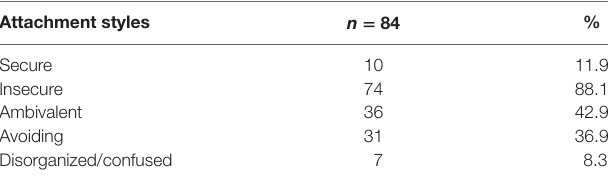
Table 4 | Attachment styles distribution among our migraine children/ adolescents.